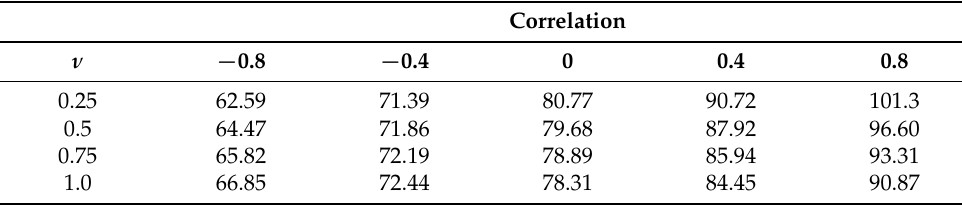
Table 5. Product of two